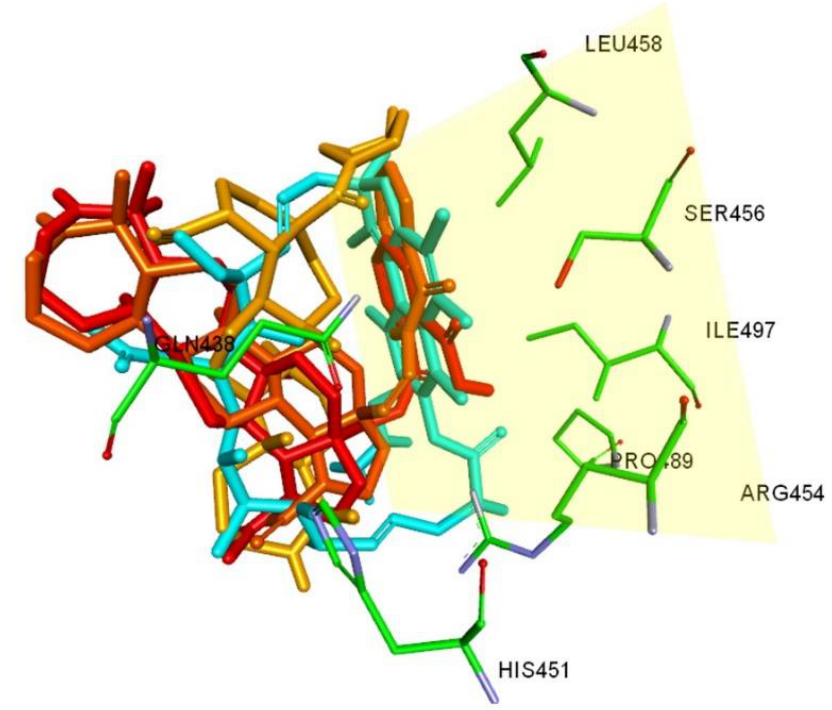
Figure 2. Rifampicin structure (light blue) overlayed on the docked conformations of compounds 4 (red), 7 (dark orange), and 9 (light orange). The highlighted yellow area shows the three compounds with the C28 side chain oriented towards the point of interaction between the rifampicin naphthyl center ring and the surrounding amino acids (green). Table 4. Recorded docking scores (binding energy, ∆G kcal/mol) for compounds 1 – 18 , 20, and 22 . The top 2 ranked active compounds are highlighted.